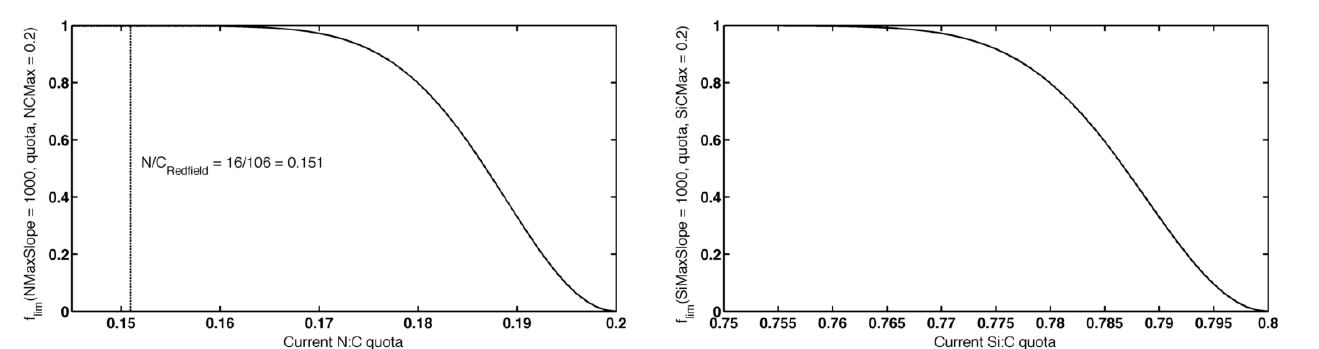
f Si:Cmax (Fig. A4) when the intracellular Si : C ratio exceeds lim a set limit. The limiter function is described in Eq. (A55) and is calculated using the following variables (Table